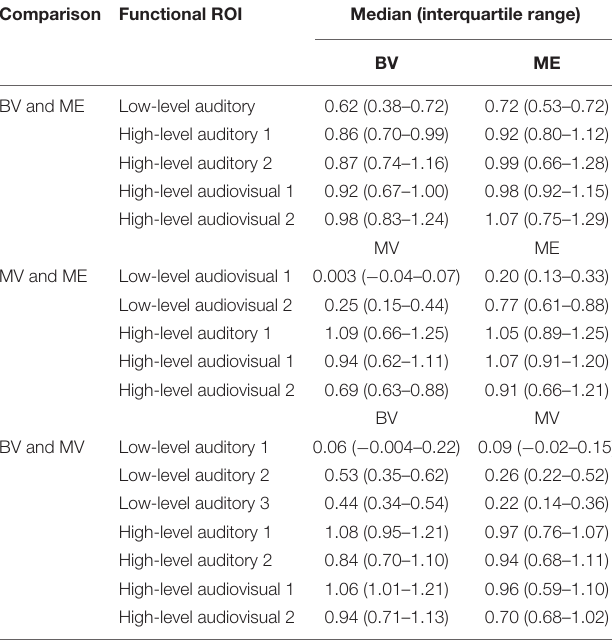
TABLE 3 | Median and interquartile range of the mean beta weight signal in each overlapping area of functional activation for auditory, visual and audiovisual stimuli isolated using conjunction analyses in localizer